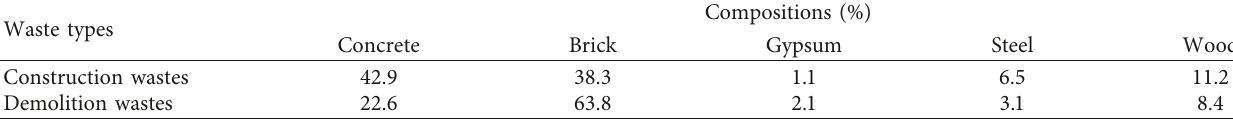
Table 1: Compositions of C&D wastes in a typical city of China [39,